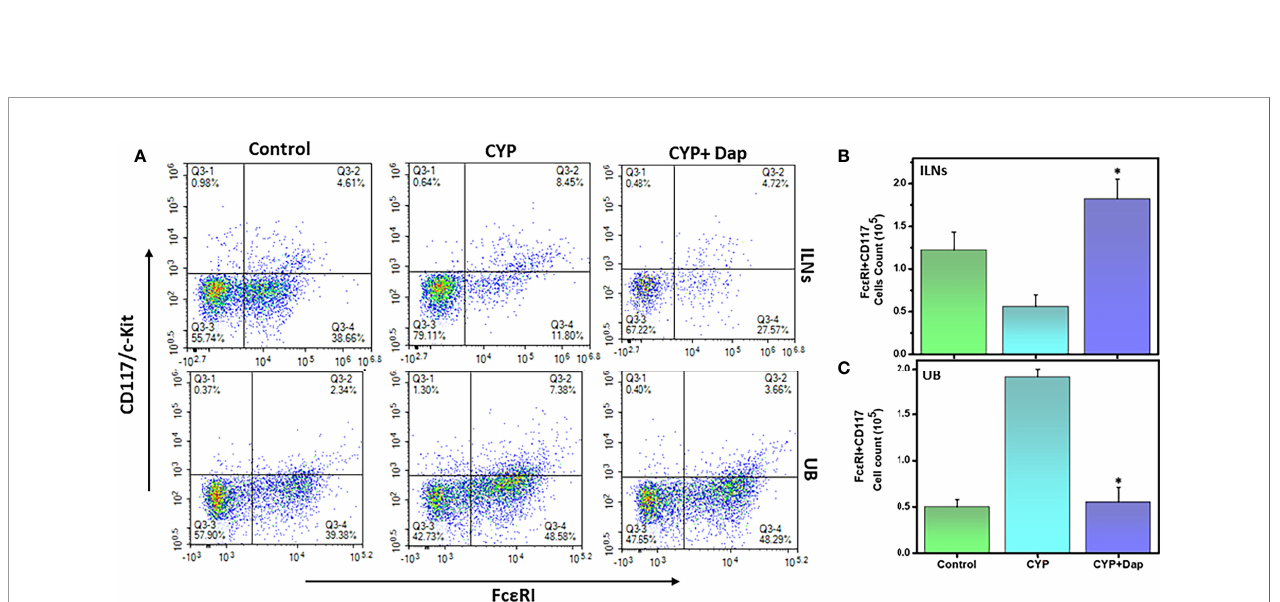
FIGURE 6 | Change in mast cells after Dap treatment during IC. Single-cell suspensions from ILN and UB were isolated from the three groups at the experimental endpoint, as described in the legend in Figure 2 . Mean values ± SEM from three independent experiments involving six mice per group (n=18) are shown. At the experimental endpoint, mast cells (MCs) were for expression of Fc e RI + CD117/c-kit, and analyzed by fl ow cytometry. Density plots are shown with the mean percentage changes in MC levels (A) and the total number of MCs in the ILNs (B) and UBs (C) per mouse. The statistical signi fi cance of fl ow cytometry data between the three groups was assessed and asterisks indicate statistically signi fi cant differences between CYP+vehicle and CYP+Dap treatment groups (*p<0.05).